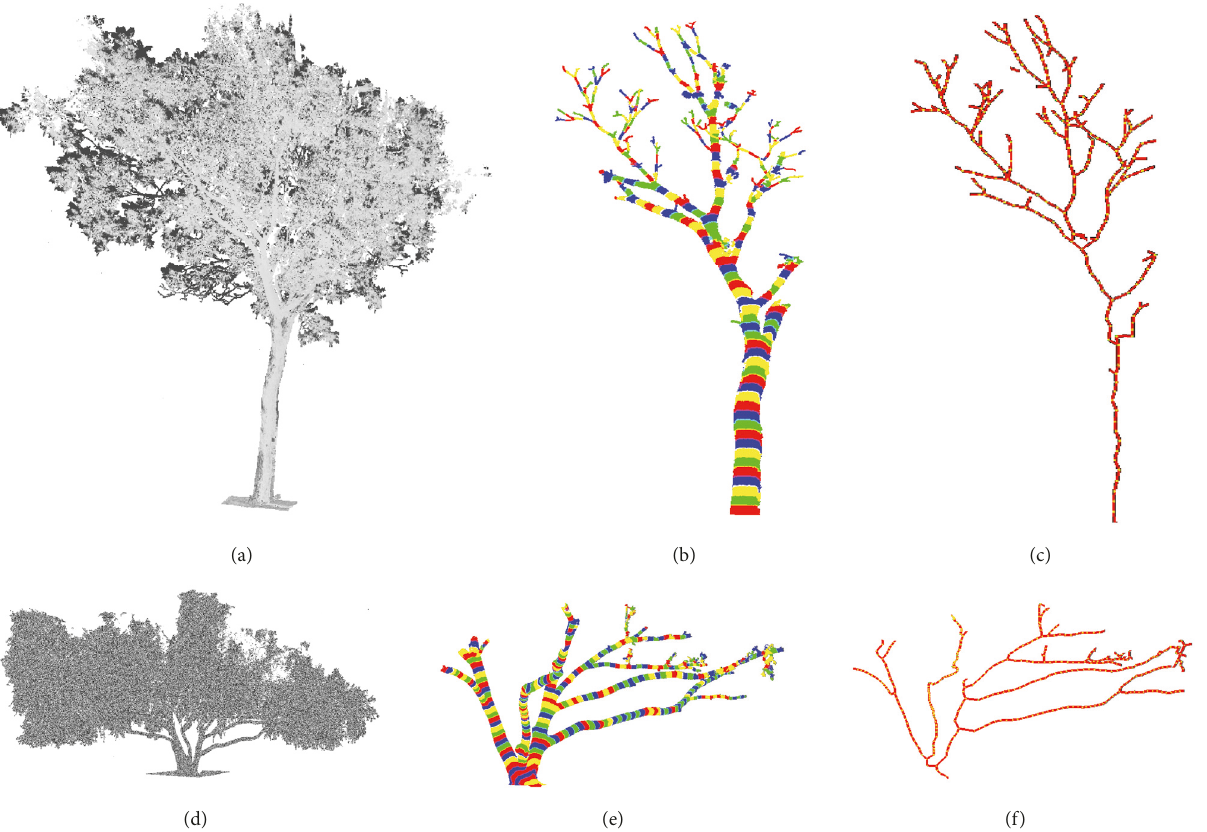
Figure 8: Skeleton extraction process. (a) is the raw point cloud data of toona tree, (b) is the outcome of toona tree point clustering, and (c) is the result of extracting toona tree skeleton. (d) is the raw point cloud data of peach tree, (e) is the outcome of peach tree point clustering, and (f) is the result of extracting peach tree skeleton.